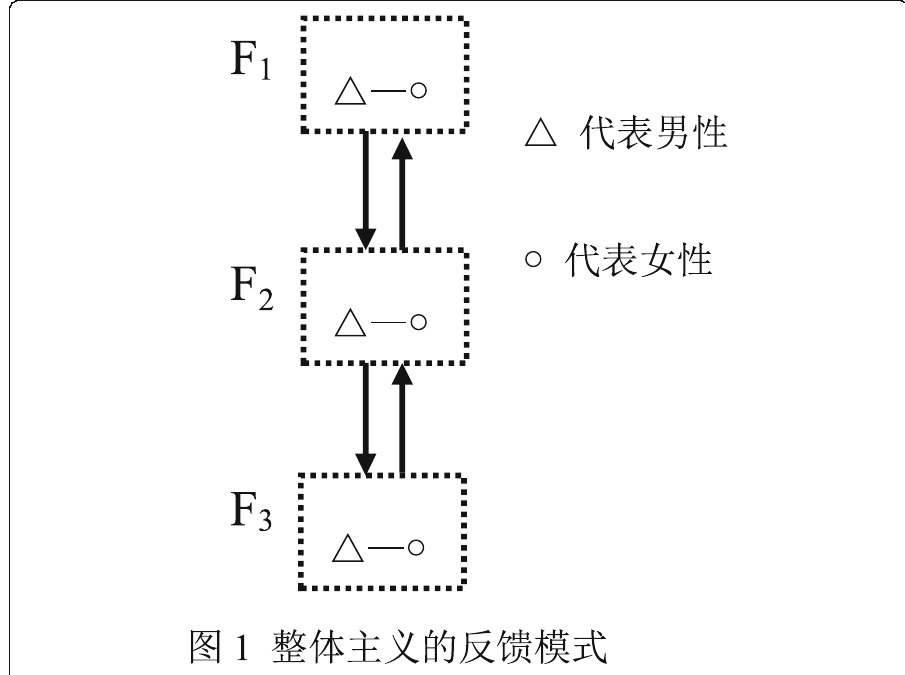
Fig. 1 The reciprocal model from holistic